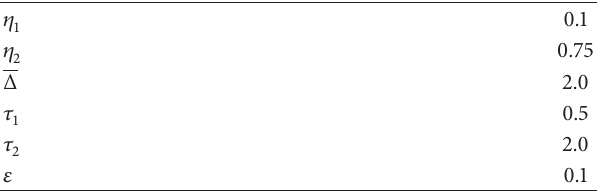
Figure 10: Fitness function curve in optimization process under 20% ITSC fault in phase A. Table 2: Parameters of trust region algorithm.